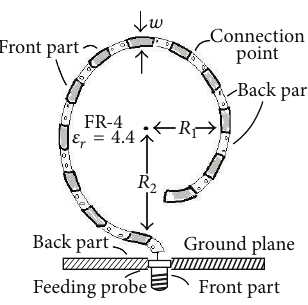
Figure 2: Single turn spiral slotted microstrip antenna